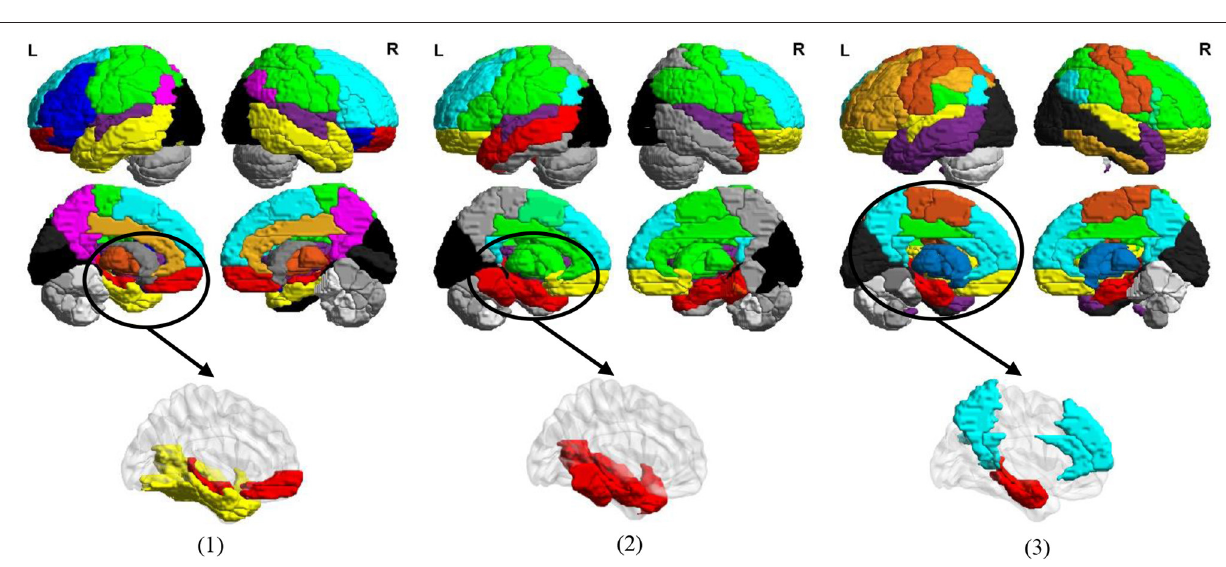
FIGURE 11 | Most discriminative modules identified by the signed spectral clustering algorithm (1st and 2nd rows) and our proposed MLFS method (3rd row) based on the selected discriminative connections in three tasks of (1) lMCI vs. eMCI, (2) eMCI vs. NC, and (3) AD vs. NC